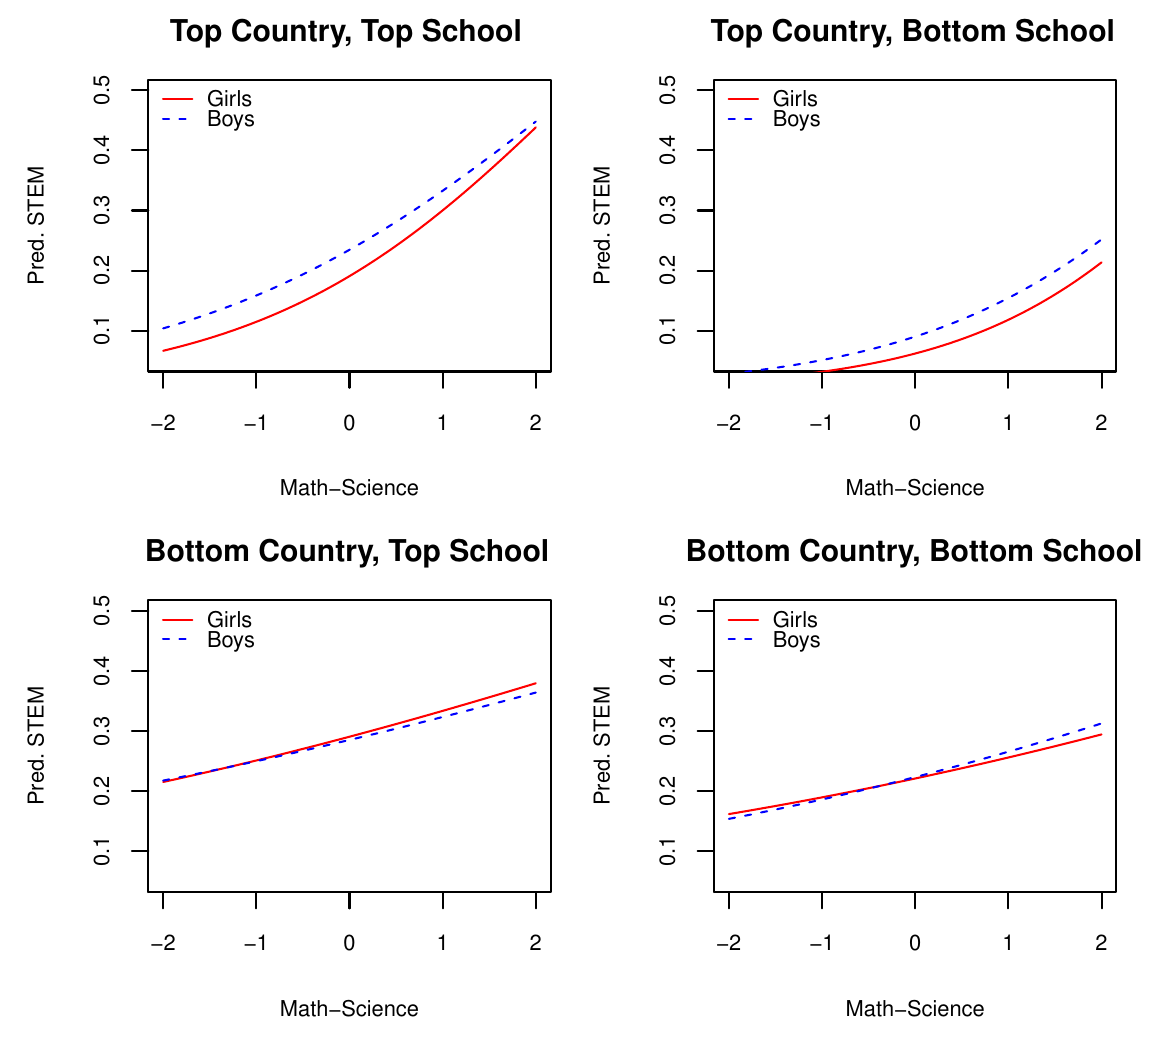
Figure 4: Predictive margins for boys and girls on the STEM orientation returns to math-science performance by the state and national performance